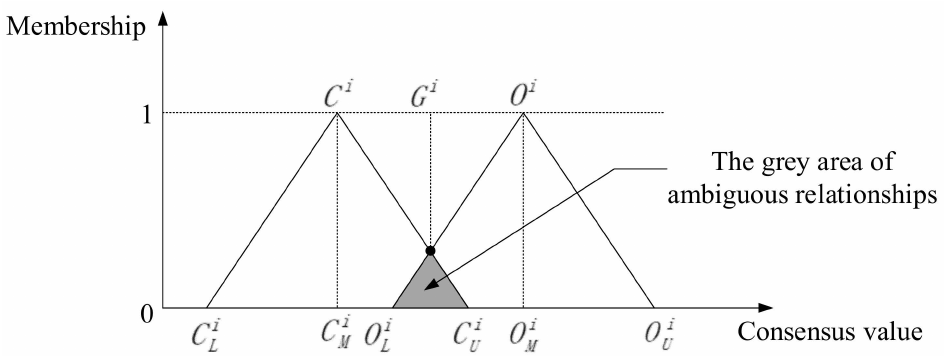
Figure 3. Schematic of FDM triangular fuzzy